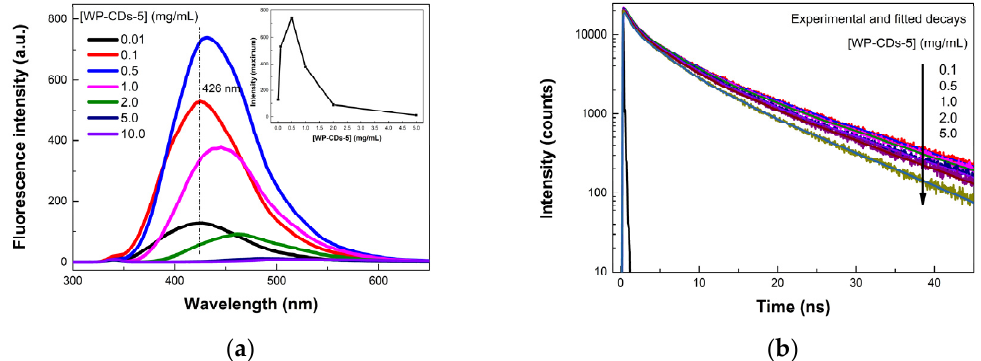
Figure 9. ( a ) Steady-state emission spectra and ( b ) time-resolved intensity decays of aqueous solu- tions of WP-CDs-5 at various concentrations, excited at 340 nm. Inset in ( a ): intensity (monitored at emission maximum) vs. concentration of CDs. Exponential decays observed near the emission maximum at each concentration (430, 435, 445, 460, and 500 nm, respectively).